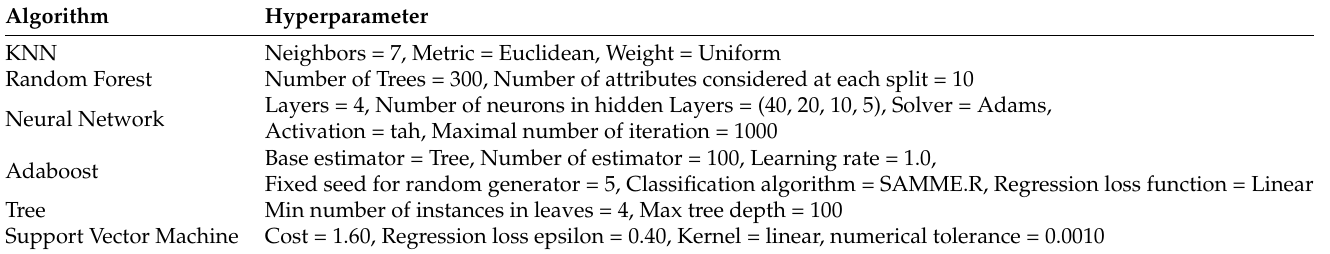
Table 5. Model hyperparameter